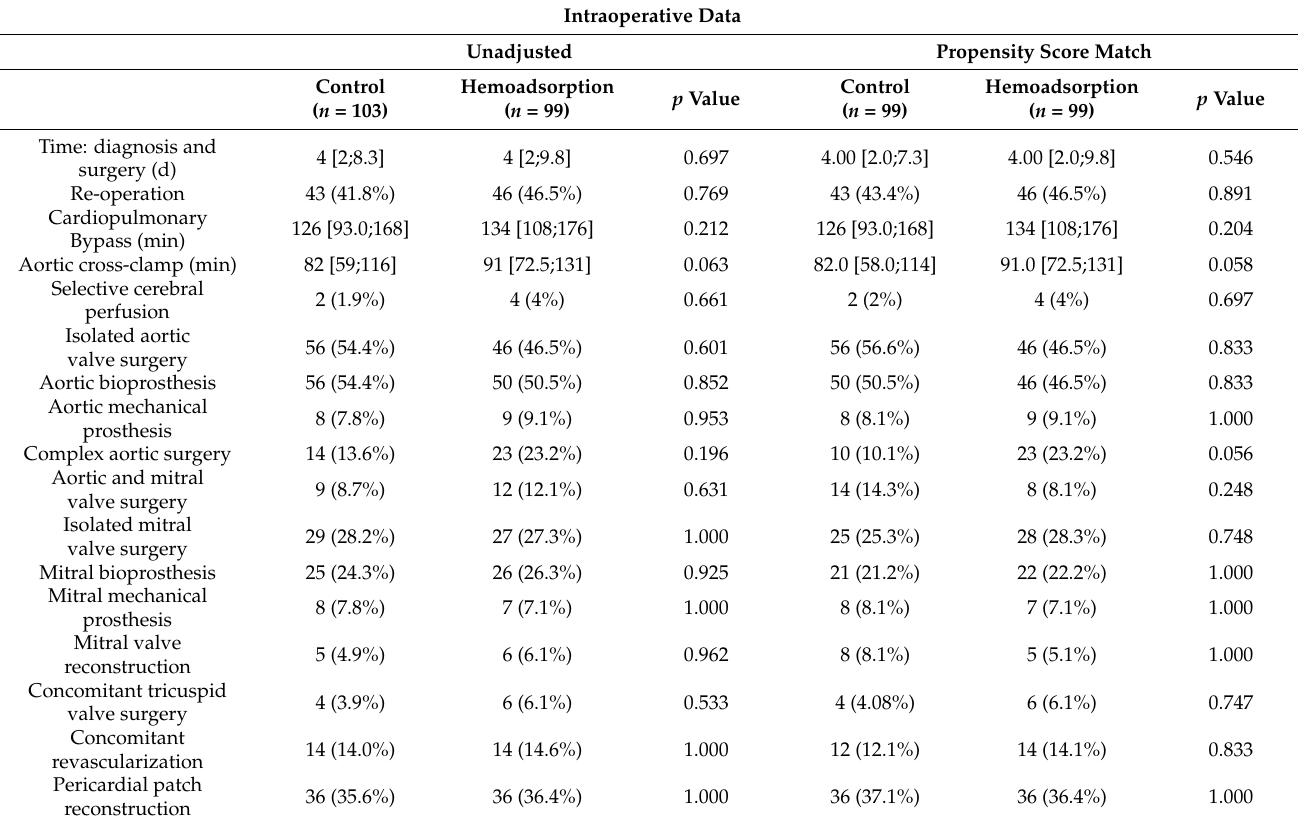
Table 2. Intraoperative data.